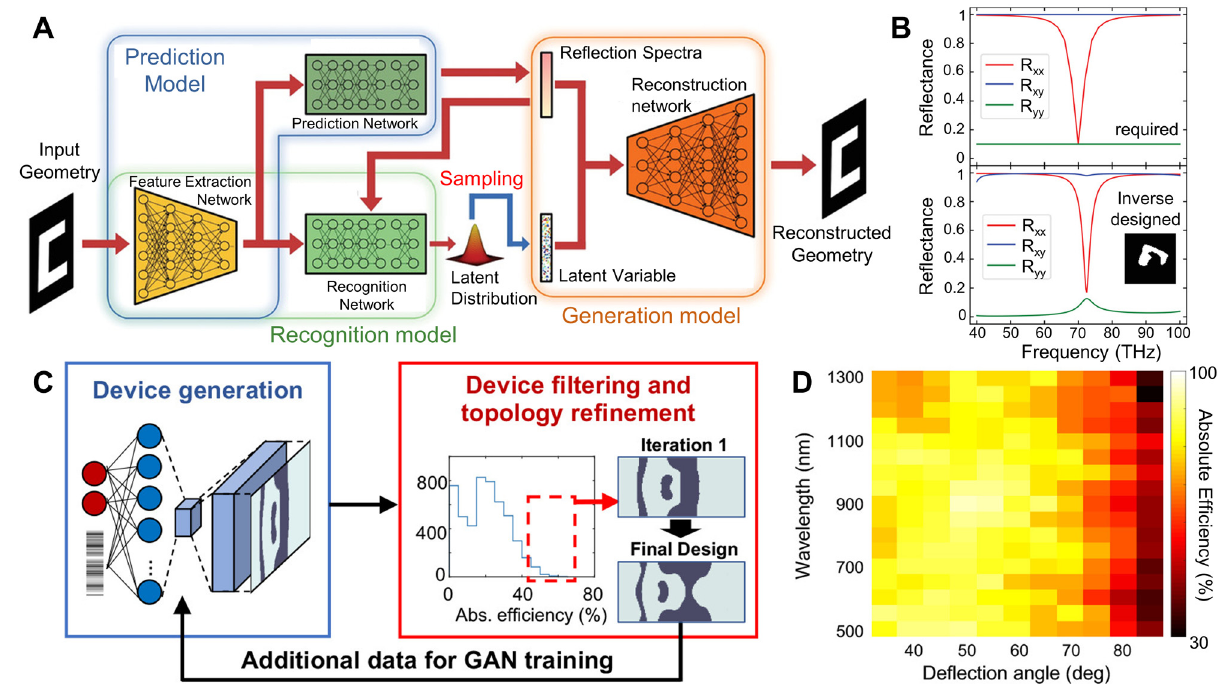
Figure 12: Use of generative models for the design of nanophotonic devices. Most generative models generate a binary image of the nanostructure, and thus removes the necessity of parametrizing the design geometry. ( A )Aschematicofvariationalautoencoderusedintheinversedesignofre fl ectancespectrum.Re fl